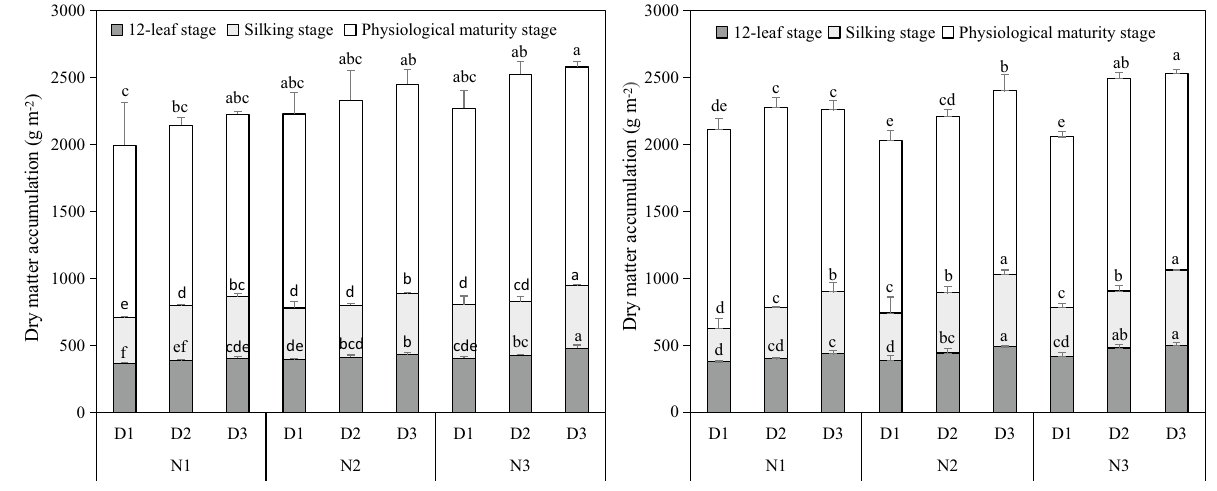
Figure 1. Dry matter accumulation of 12 leaf stage, silking stage and maturity stage in 2017 (left) and 2018 (right). The three N rates are 120 (N1), 180 (N2), and 240 (N3) kg ha −1 . The three planting density levels are 60,000 (D1), 75,000 (D2), and 90,000 plants ha −1 (D3). Symbols represent means ± standard error. Vertical bars indicate standard error. Different letters within the same stage are significantly different at the 0.05 probability level.